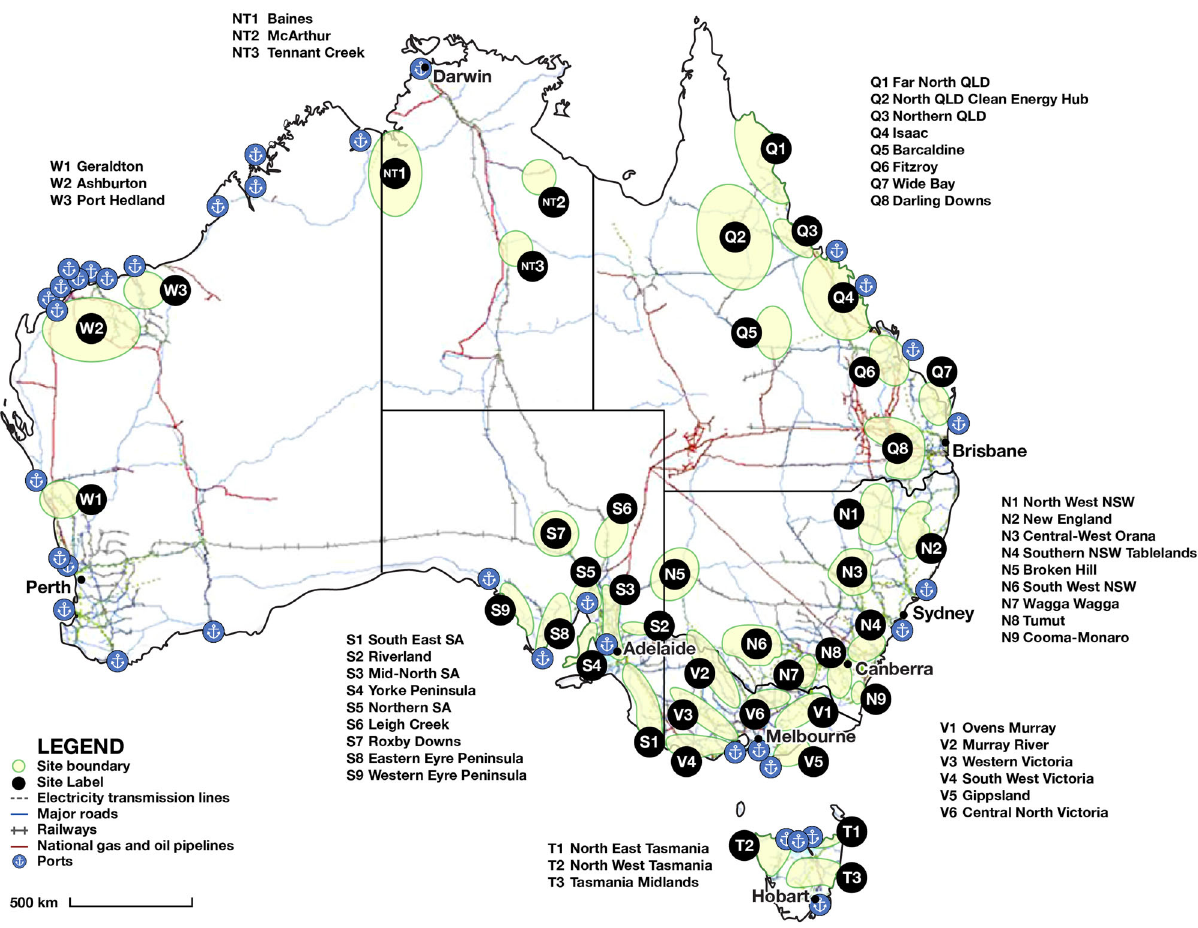
Fig. 2 Map of potential hydrogen generation zones selected for the analysis. The maps show the considered renewable energy zones (potential sites for green electrolysis projects), existing electricity transmission lines, roads, railways, gas and oil pipelines and port infrastructure. The location of the NEM connected REZs were adopted from the AEMO ISP, the rest of the locations for WA and NT were drawn to approximation (region with same solar and wind traces). The data for the infrastructure (road, rail, electricity transmission lines, natural gas/oil pipelines and port locations) and the map of Australia were adopted from data made available by Commonwealth of Australia (Geoscience Australia) under Creative Commons Attribution 4.0 International Licence 26